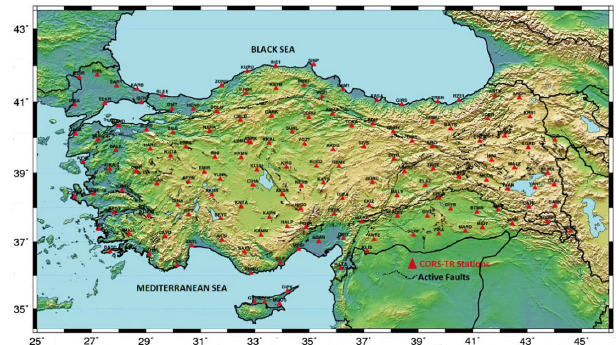
Figure 2. CORS-TR stations; Yildirim et al. (2013).